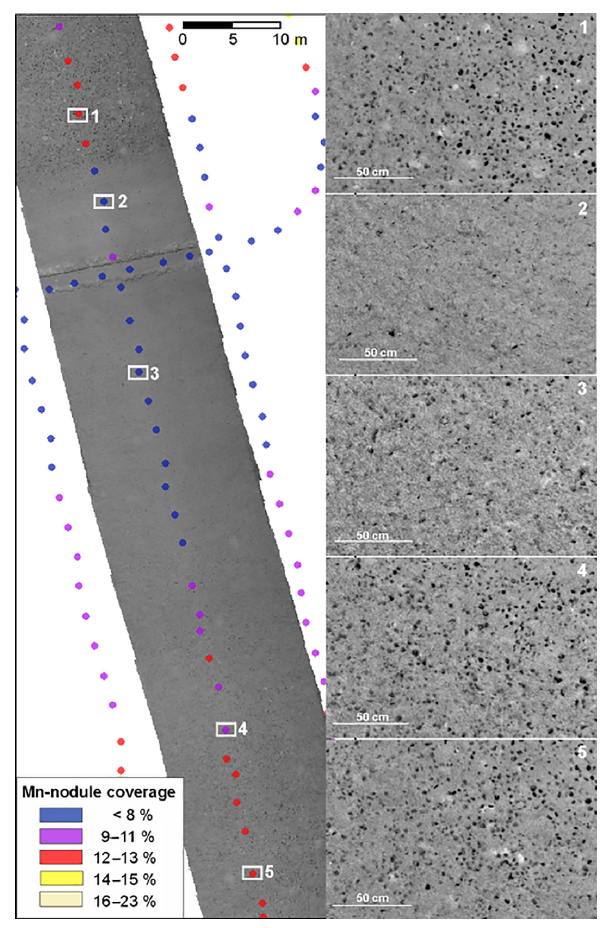
Figure 10. Section of the photo mosaic along one survey track line, with calculated nodule coverage values, indicated by the color- coded dots (representative of the center of each individual photo which are approximately 15m × 11.5m (172m 2 ) in size). White squares mark positions of the enlarged photos shown to the